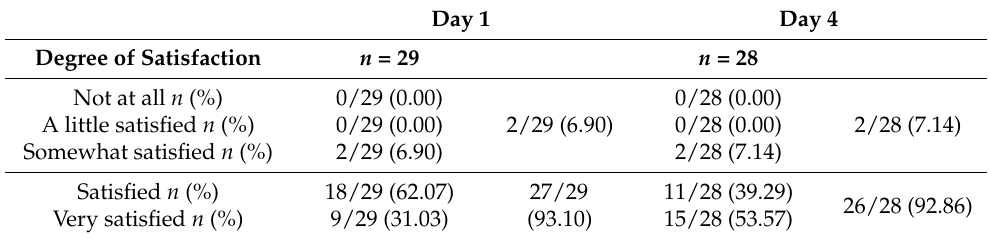
Table 4. Degree of satisfaction of the application of honey (intervention